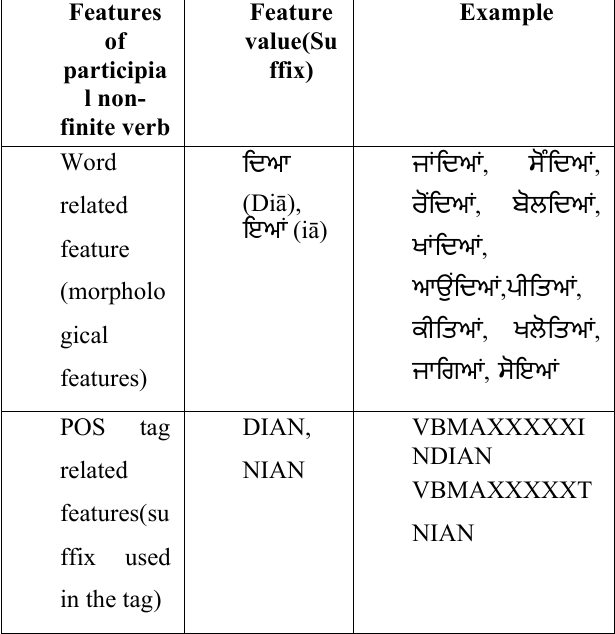
Table 2. Features of participial non-finite verb Features